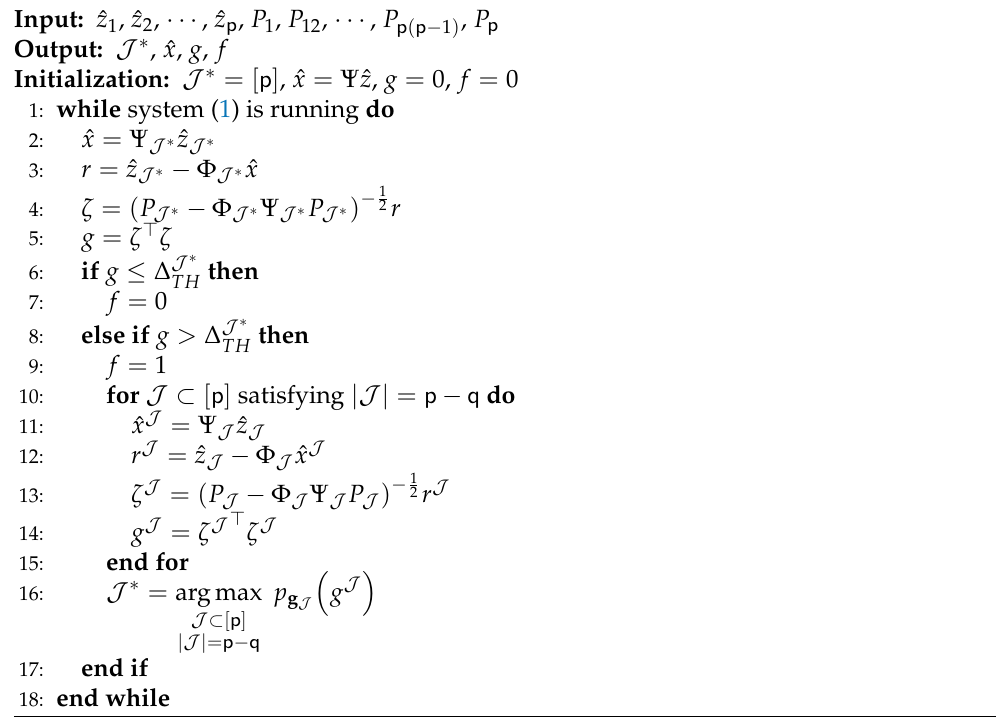
Algorithm 2 Operation of the resilient estimation with Gaussian